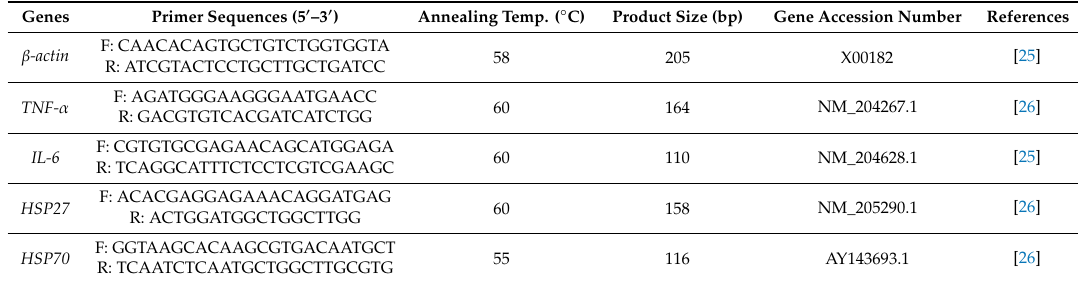
Table 1. Primer sequences used in real-time